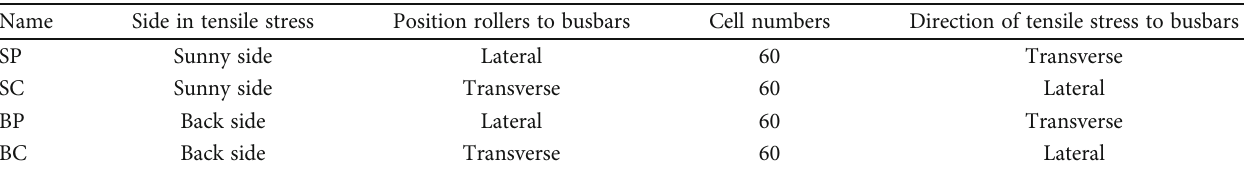
Table 2: Solar cell strength testing in four-point bending is performed using batches and con fi gurations of samples.